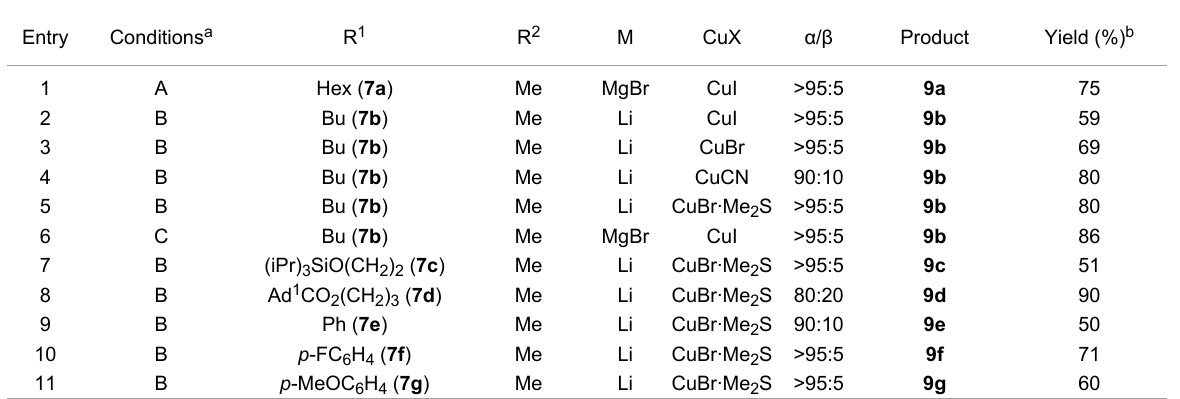
Table 3: Carbometallation reactions of cyclic N -alkynylcarbamates 7 (Scheme 4).